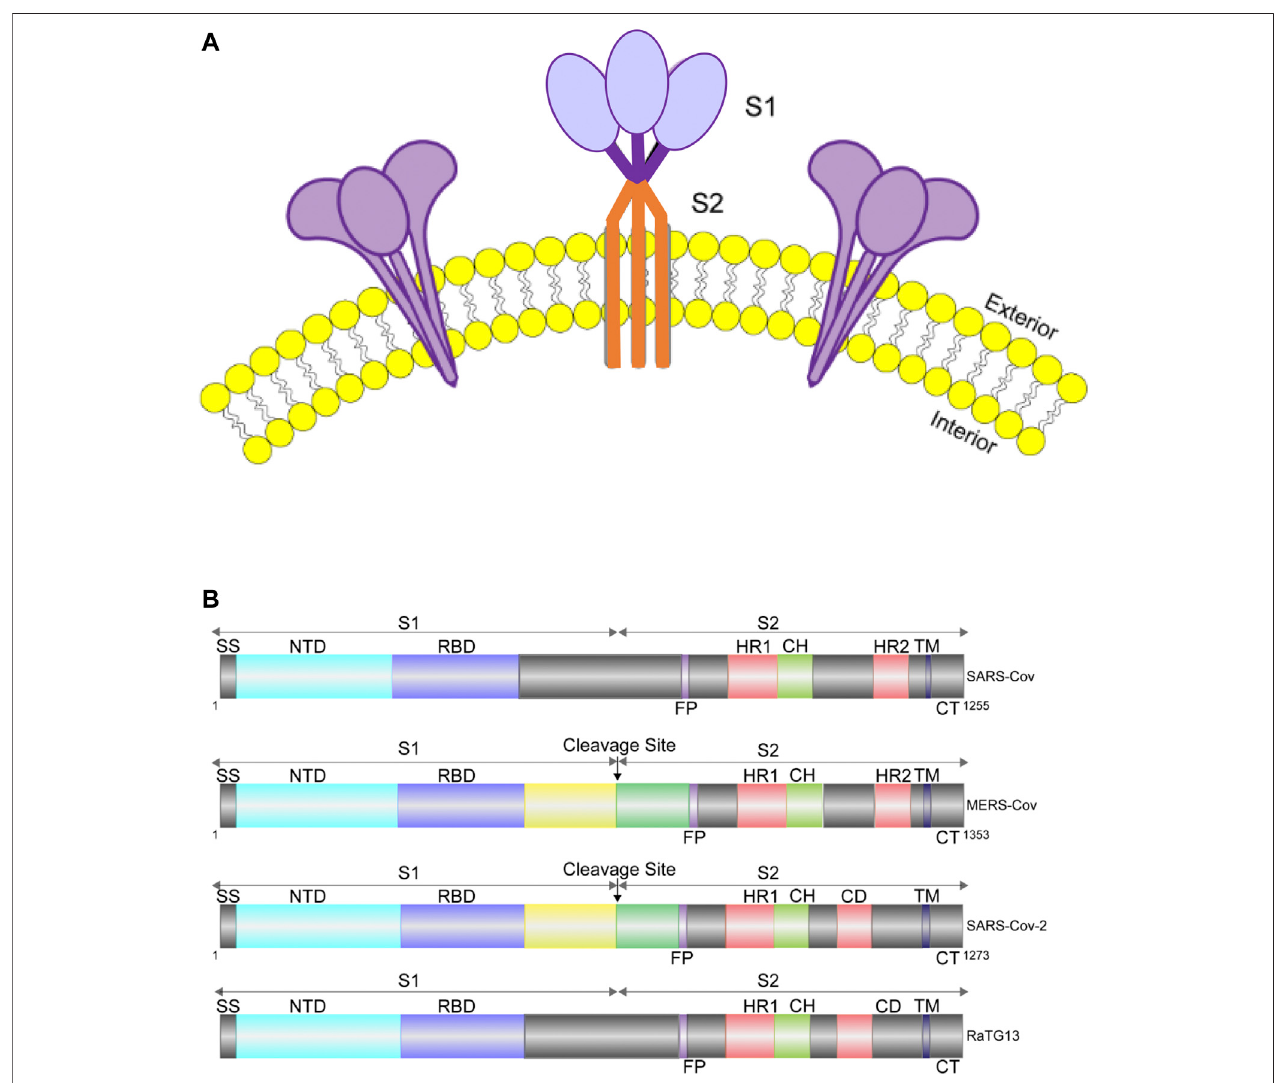
FIGURE 1 | Cartoon representation of S protein structures. (A) . Diagram of S protein trimers on viral envelope (yellow: lipid bilayer). (B) . Diagram showing the domain organization of the S proteins of SARS-CoV, MERS-CoV, RaTG13 and SARS-CoV-2. MERS-CoV and SARS-CoV-2 can be cleaved into S1 and S2 by cellular protease, while SARS-CoV and RaTG13 cannot. SS, signal sequence; RBD, receptor-binding domain; FP, fusion peptide; HR1, heptad repeat 1; CH, central helix; CD, connector domain; HR2, heptad repeat 2; TM, transmembrane domain; CT, cytoplasmic tail.